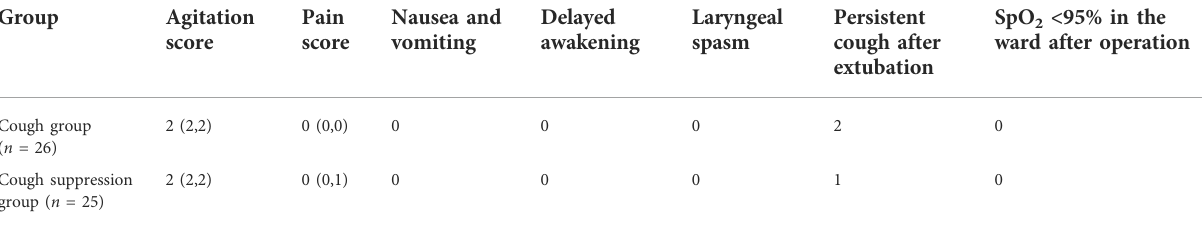
TABLE 4 Comparison of postoperative complications between the two groups.